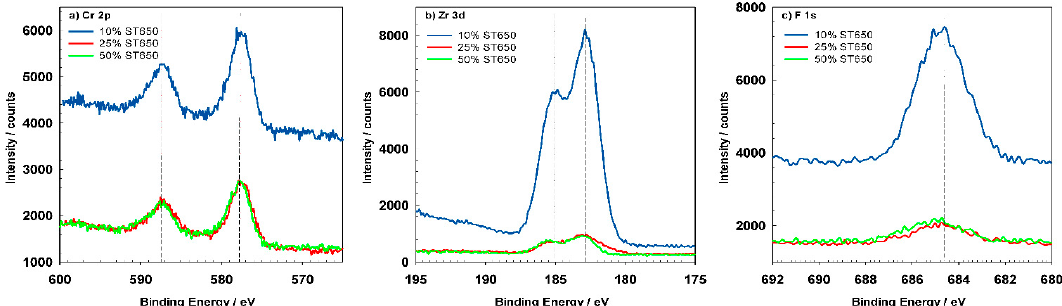
Figure 11. High-resolution XPS spectra of ( a ) Cr 2p ; ( b ) Zr 3d ; ( c ) F 1s recorded for AA3003 samples coated with ST650 conversion coatings of different concentrations: 10%, 25% and 50%. The conversion time was 18 min at room temperature. Spectra were not normalized on the intensity scale.